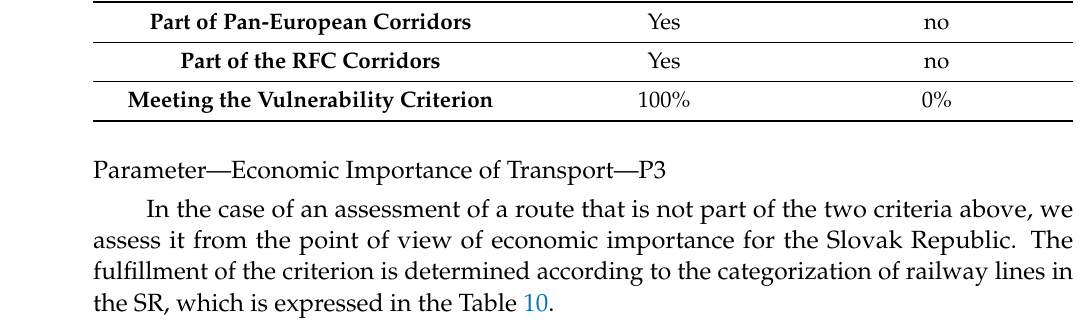
Table 9. Significance of the Railway Lines.